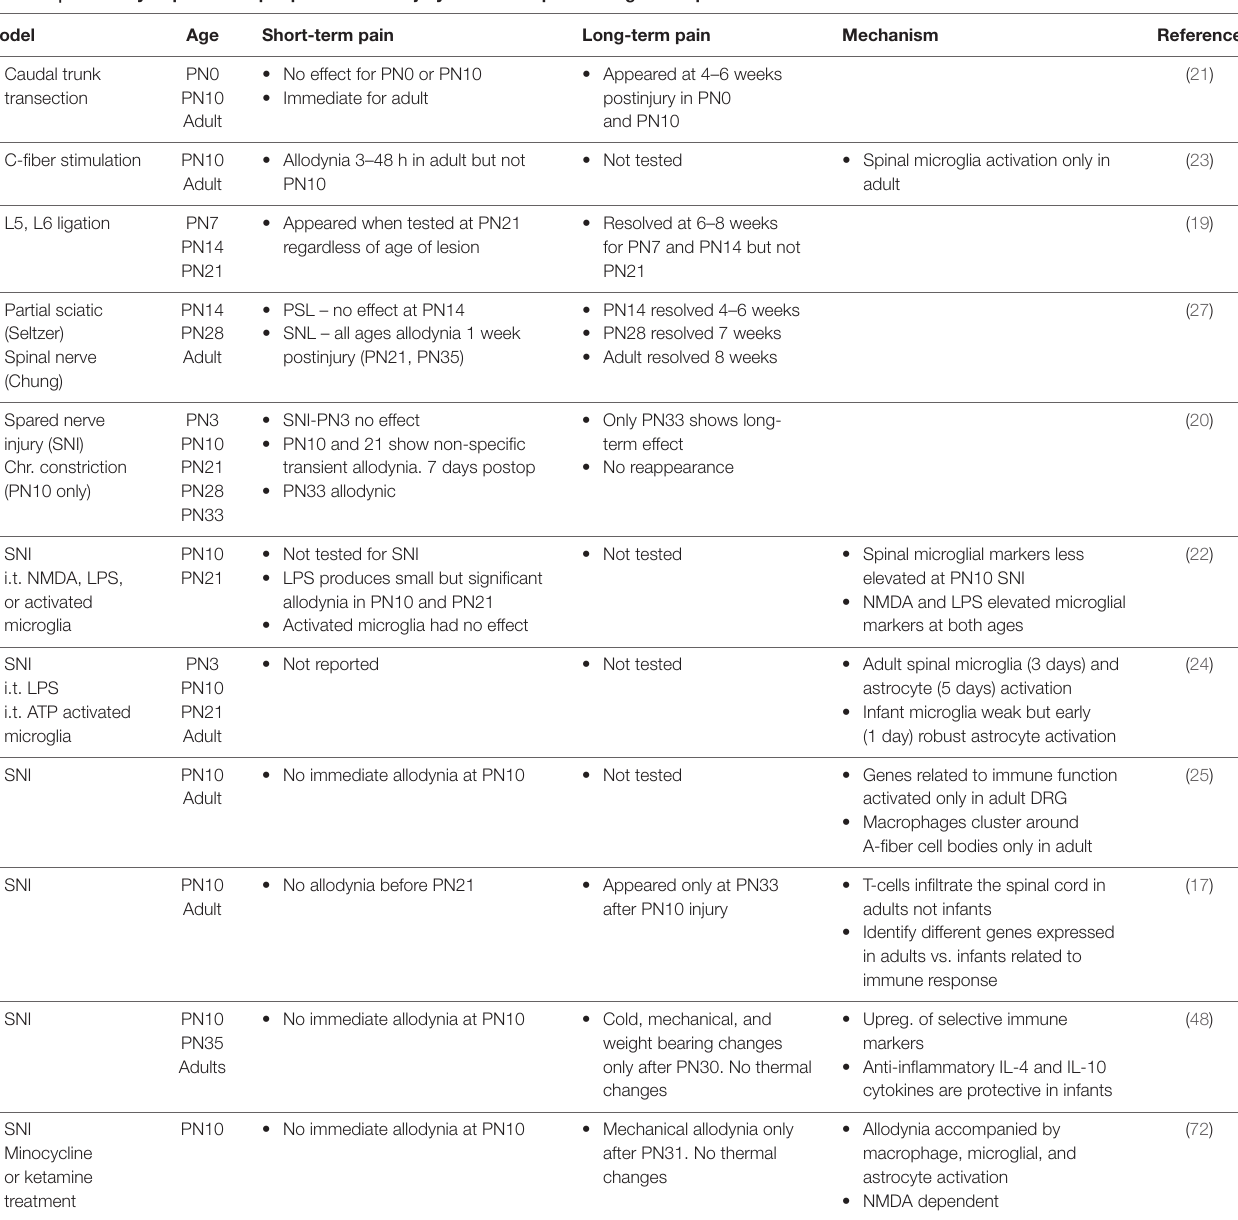
Table 1 | summary of published peripheral nerve injury studies on pain during